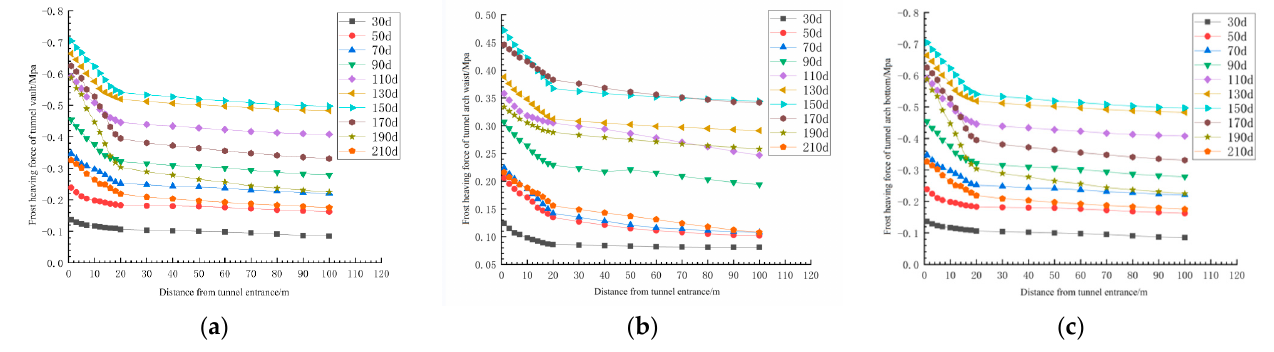
Figure 9. Variation curve of frost heaving force that changes over time and depth. ( a ) Tunnel vault. ( b ) Tunnel arch waist. ( c ) Tunnel arch bottom.